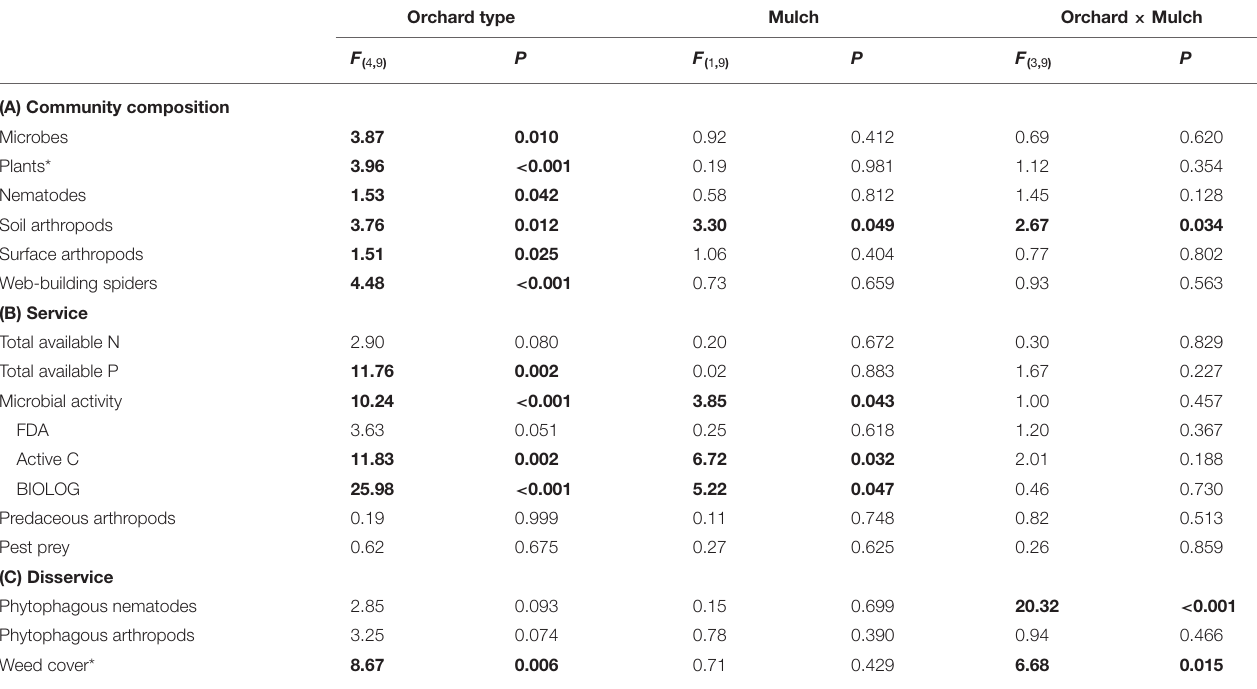
TABLE 3 | Effects of Orchard type and mulch treatment on (A) community composition (taxonomic composition), (B) ecosystem service, and (C) ecosystem disservice potentials in organically (apricot, peach, plum, and quince) and conventionally (apricot) managed